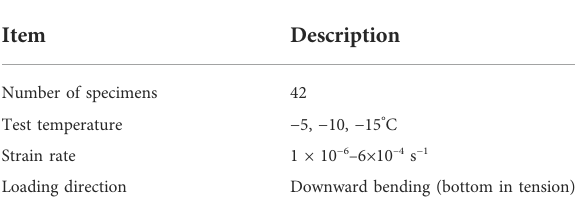
TABLE 1 Overview of the three-point bending test conditions.